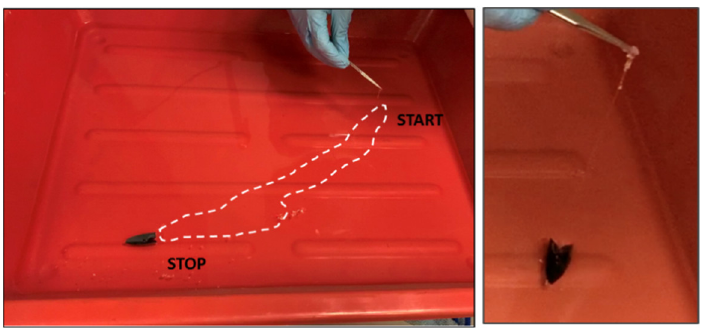
Figure 7. ( a ) When the boat is free to move over a bigger surface, we observed the propulsion from one side to the opposite one. On-the-fly formed polymer film is indicated by the dotted line. ( b ) The recovered polymeric film attached to the back of the boat is visible.